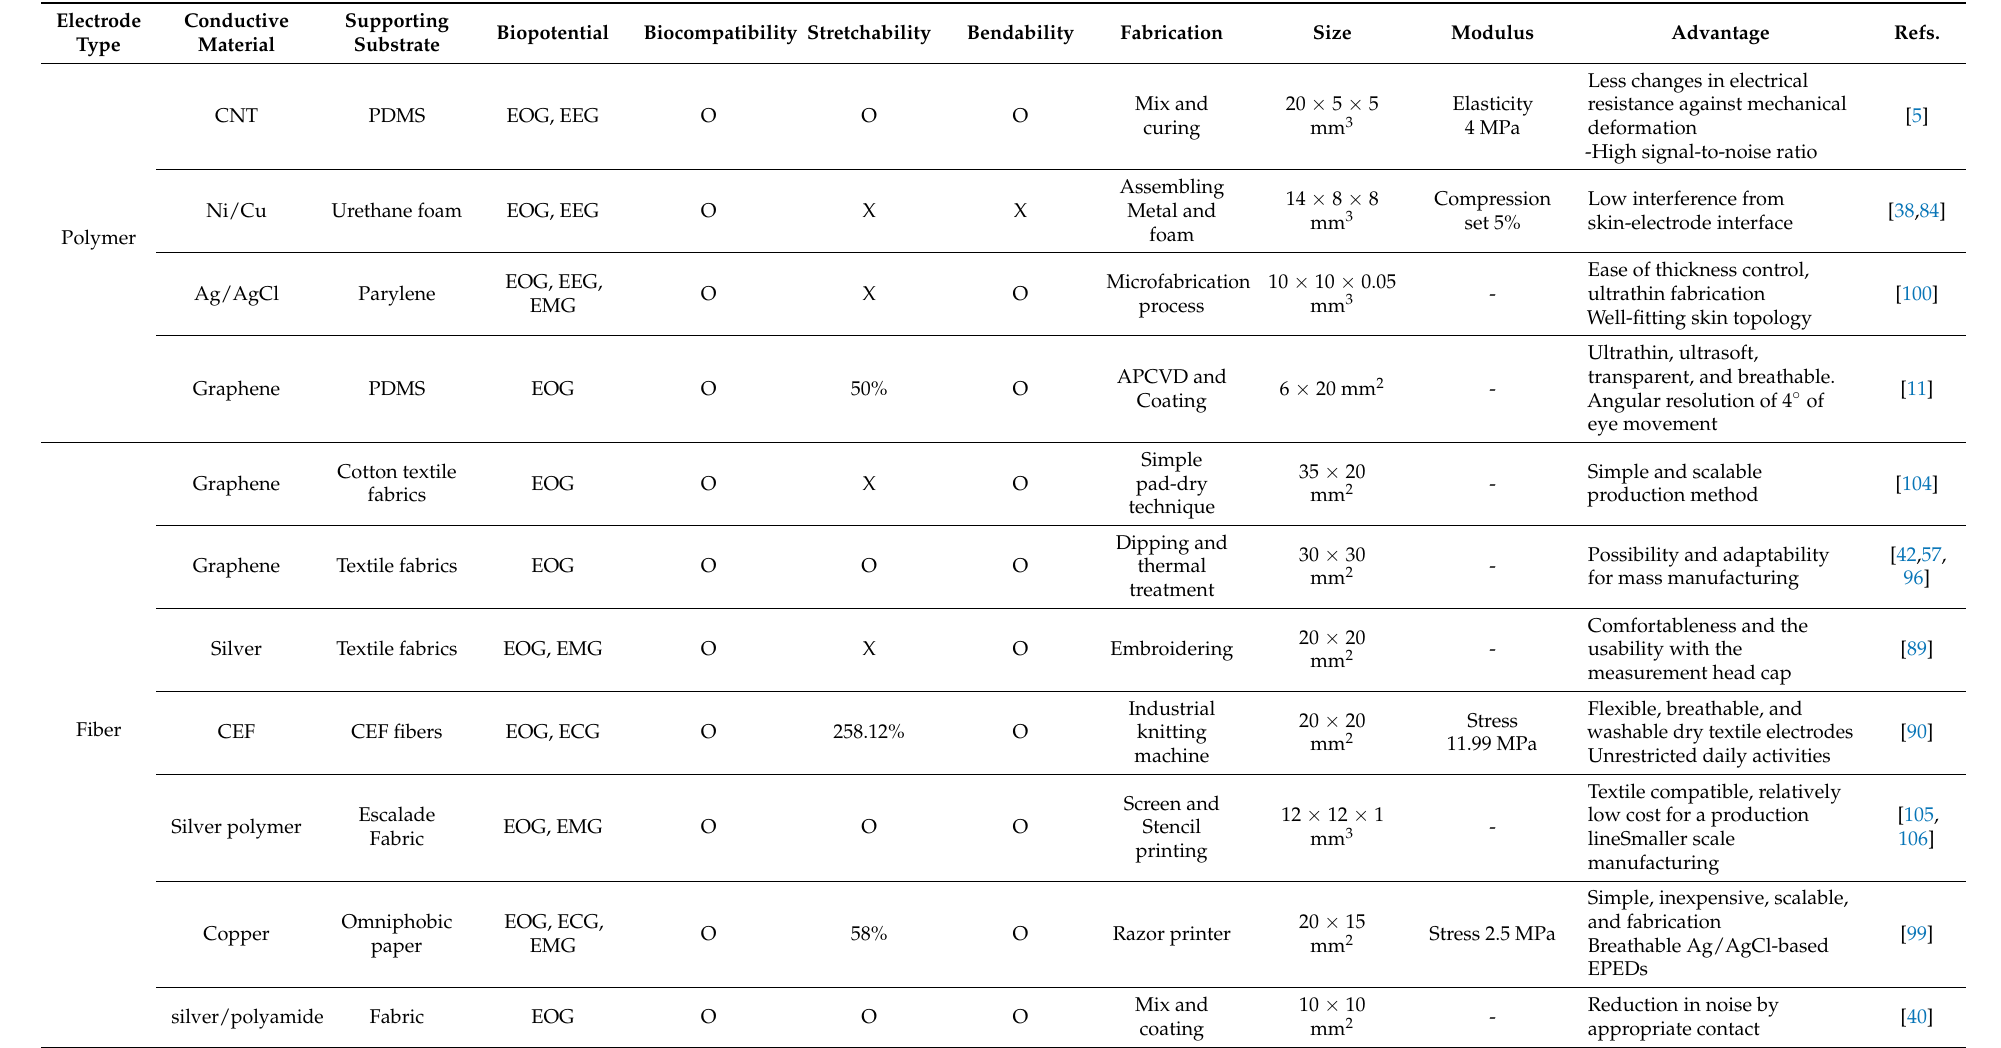
Table 1. Summary of electrodes for measuring EOG